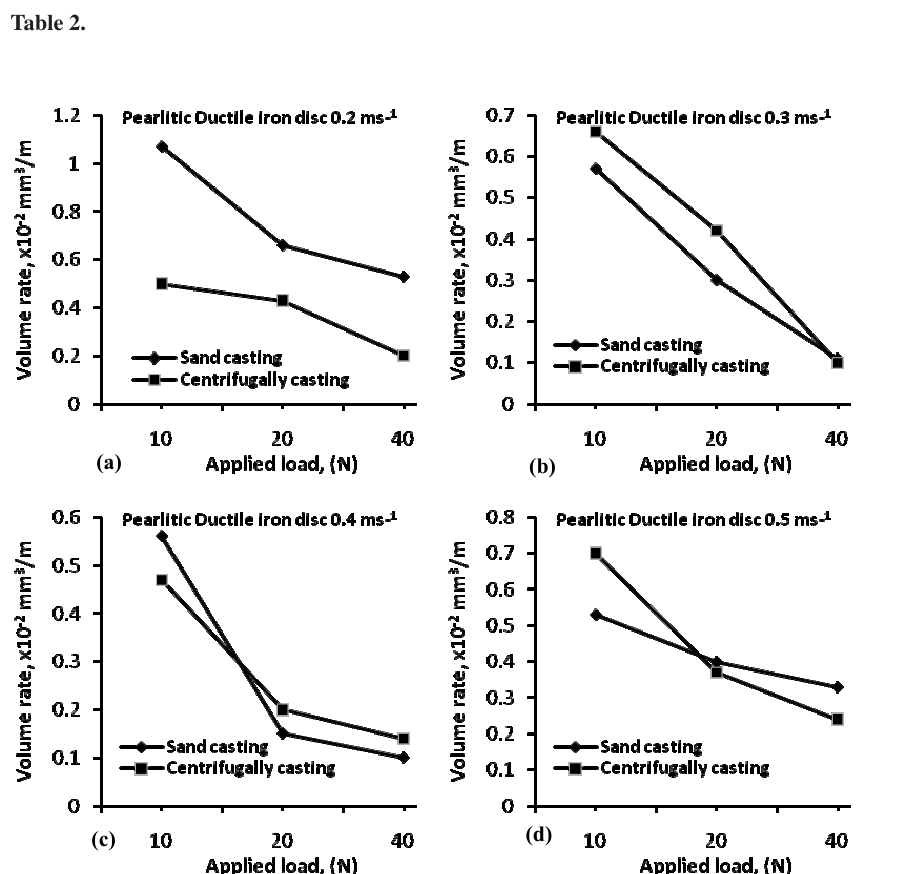
Figure 4. Variation of volume rate vs. applied loads at constant sliding distance (600 m) and different sliding